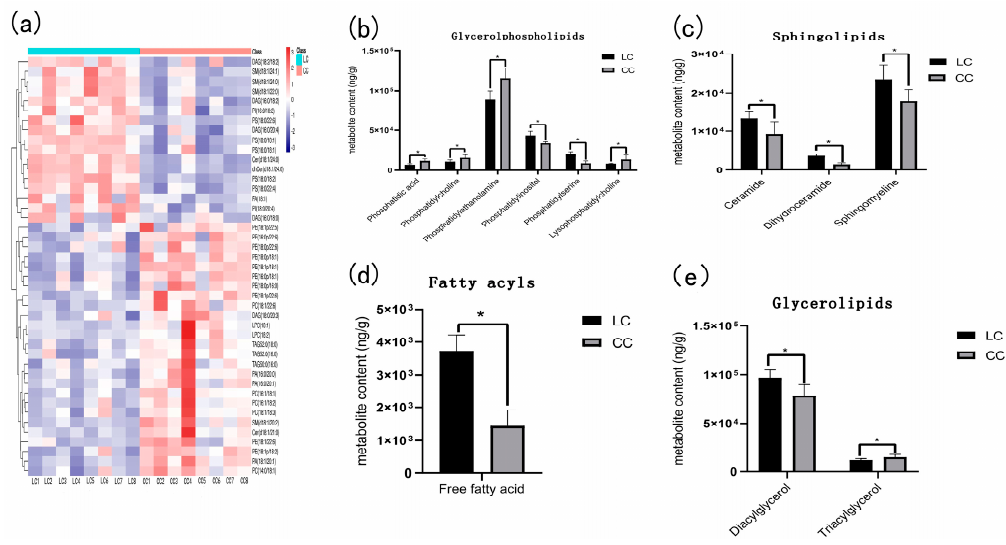
Figure 3. Heatmap and statistical histogram of liver differential metabolites between Huainan Partridge chicken (LC) and Nongda III (CC). * represents the significant difference of p < 0.05. ( a ) Heatmap of liver differential metabolites between two groups. ( b ) The content of glycerol phospholipid metabolites in two groups. ( c ) Sphingolipids content of LC and CC groups. ( d ) Fatty acyls content of LC and CC groups. ( e ) The content of glycerolipids metabolites between two groups.